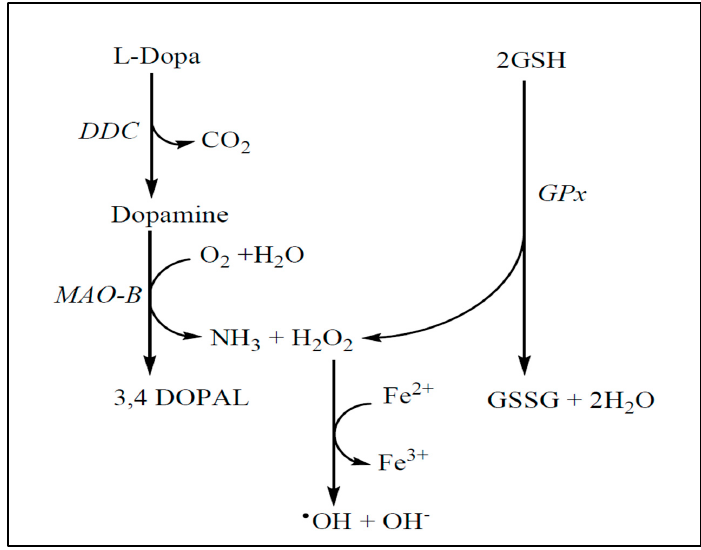
Figure 4. A potential mechanism of dopamine metabolism and OH • radical formation in the striatum of PD patients as a consequence of iron accumulation and decline in GSH levels. DDC: dopa decarboxylase; 3,4 DOPAL: 3,4-dihydroxyphenylacetaldehyde.